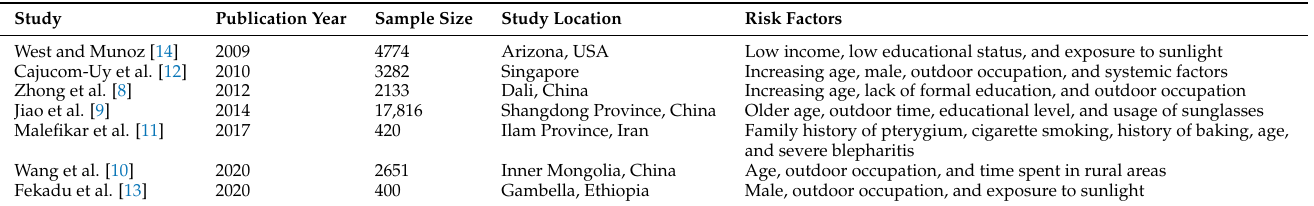
Table 1. Summary of the risk factors of the pterygium